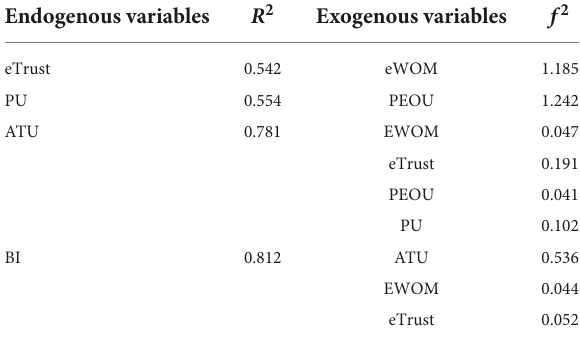
TABLE 6 Predictive relevance and effect